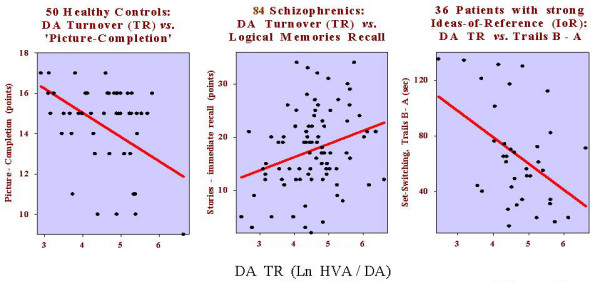
Partial correlations (left) show that reduced dopamine turnover (DA TR: Ln HVA/DA) is associated with enhanced picture completion scores in healthy subjects (r = -0.35, P = 0.01). Increasing DA TR (middle) is associated with improved verbal recall in patients with schizophrenia (r = +0.29, P = 0.008). For patients with high ratings for ideas-of reference (IoR: right) increased DA activity was associated with promoting the speed of switching between sets on the trail-making test (r = +0.34, P = 0.015).